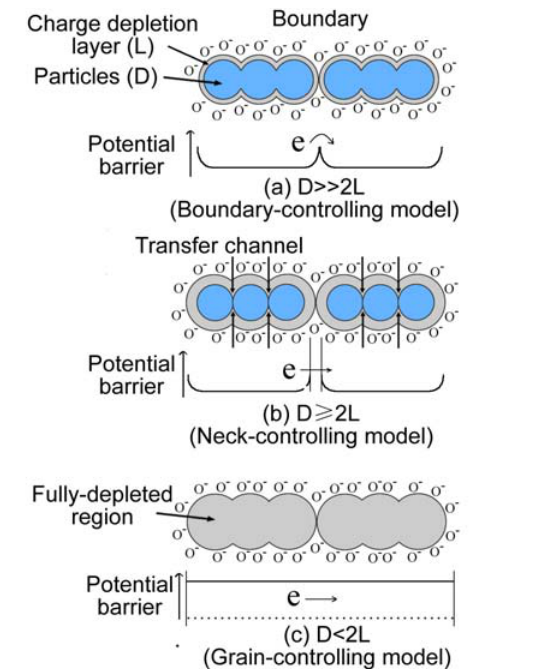
Figure 4. Schematic model of the effect of the crystallite size on the sensitivity of metal-oxide gas sensors: ( a ) D >> 2L; ( b ) D ≥ 2L; ( c ) D < 2L.